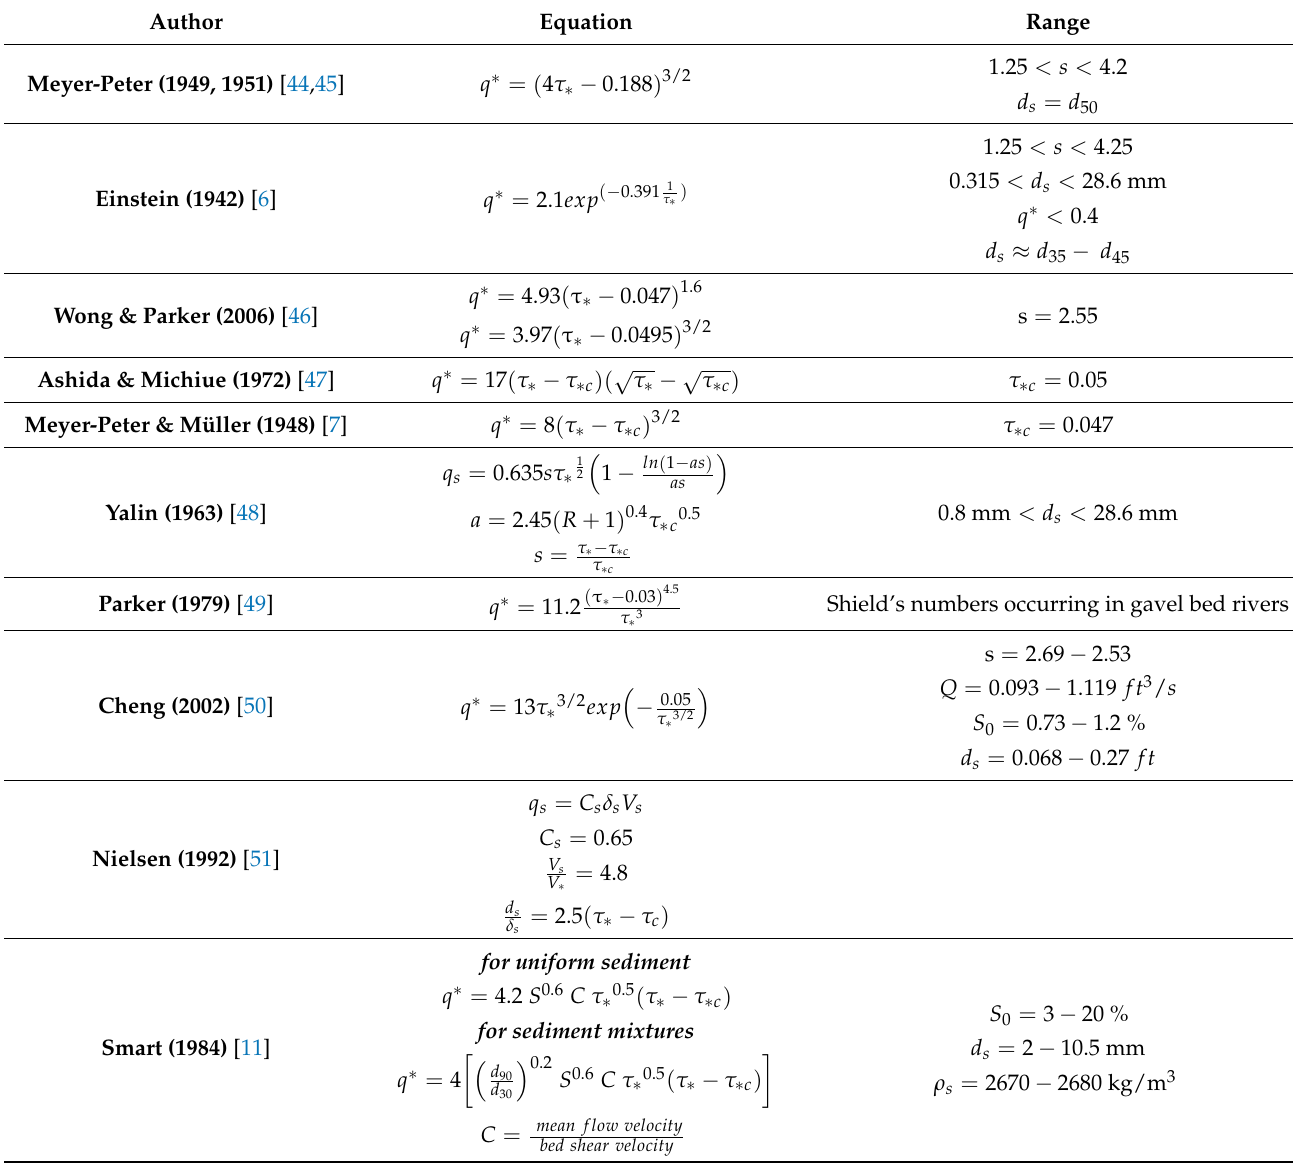
Table 1. Equations to compute bedload transport rate in gravel bed